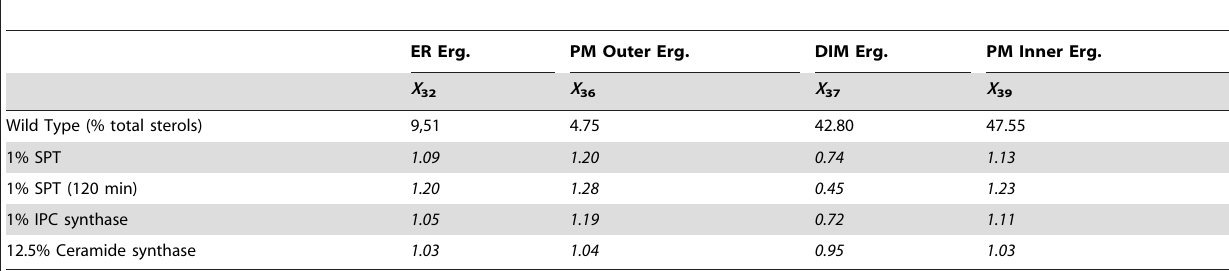
Table 1. Steady-state total mass of ergosterol sub-populations in the SL-E model under different experimental conditions, after 60 min.